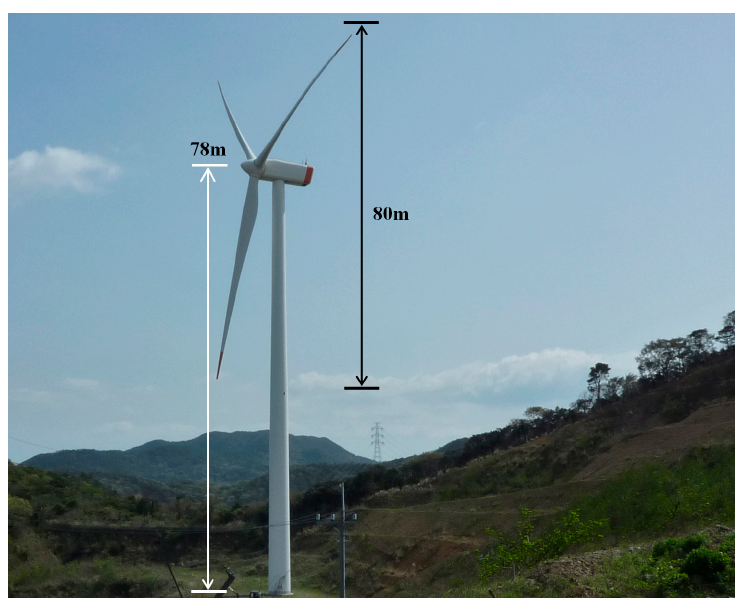
Figure 3. A photo of WT1 (Wind Turbine 1) showing specifications of the wind turbines. Table 1. Summary of the Atsumi Wind Farm.